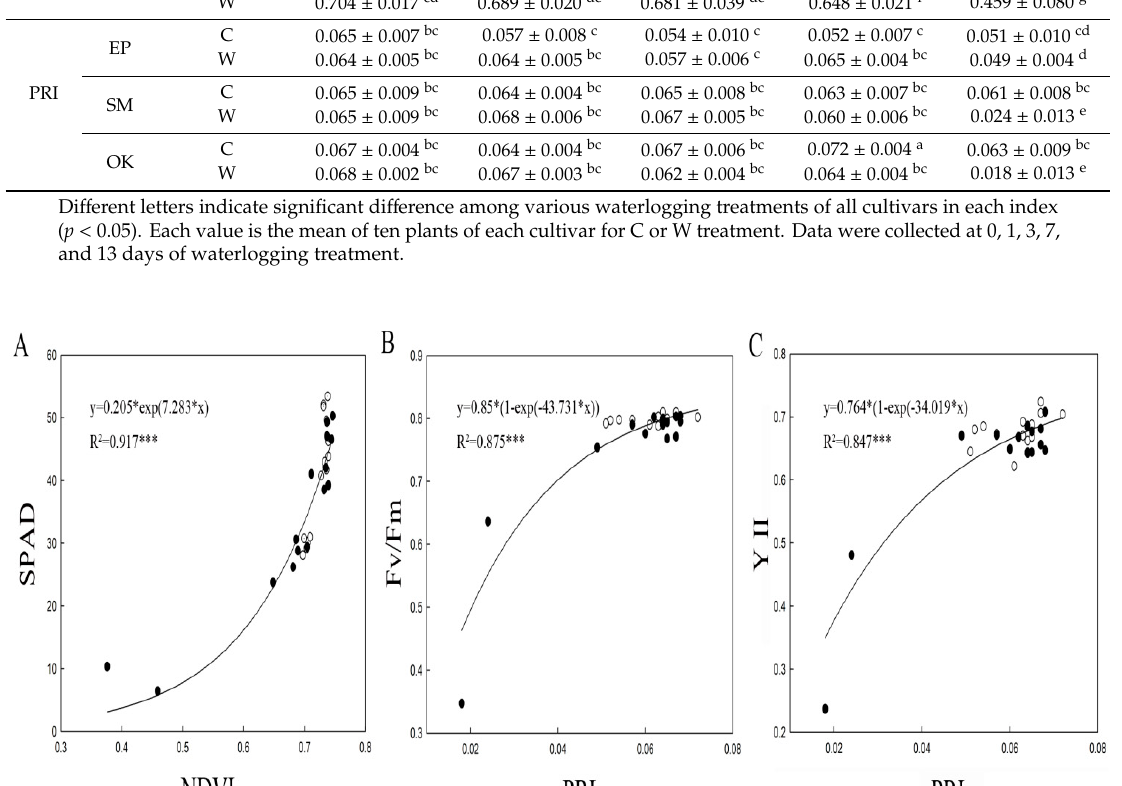
Figure 3. The regression correlations between ( A ) SPAD and NDVI, ( B ) Fv / Fm and PRI, and ( C ) YII and PRI in plants under control and waterlogging treatments. Each symbol represents the average of ten plants which were randomly selected from each treatment. Each NDVI or PRI index was calculated using leaf SPAD, Fv / Fm , and YII data ( n = 30) from the model validation datasets. The R 2 coe ffi cients of NDVI and PRI with leaf SPAD, Fv / Fm, and YII were calculated. The white circle represents data from control treatments, whereas the black circle represents data from waterlogging treatments. *** p <